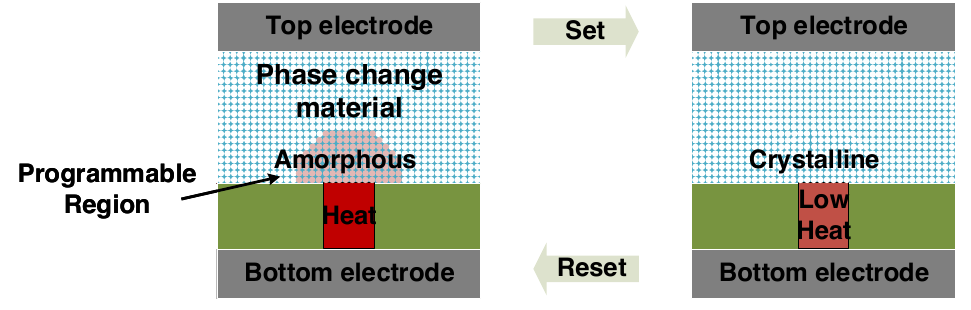
Figure 4. A PRAM device design that has phase change